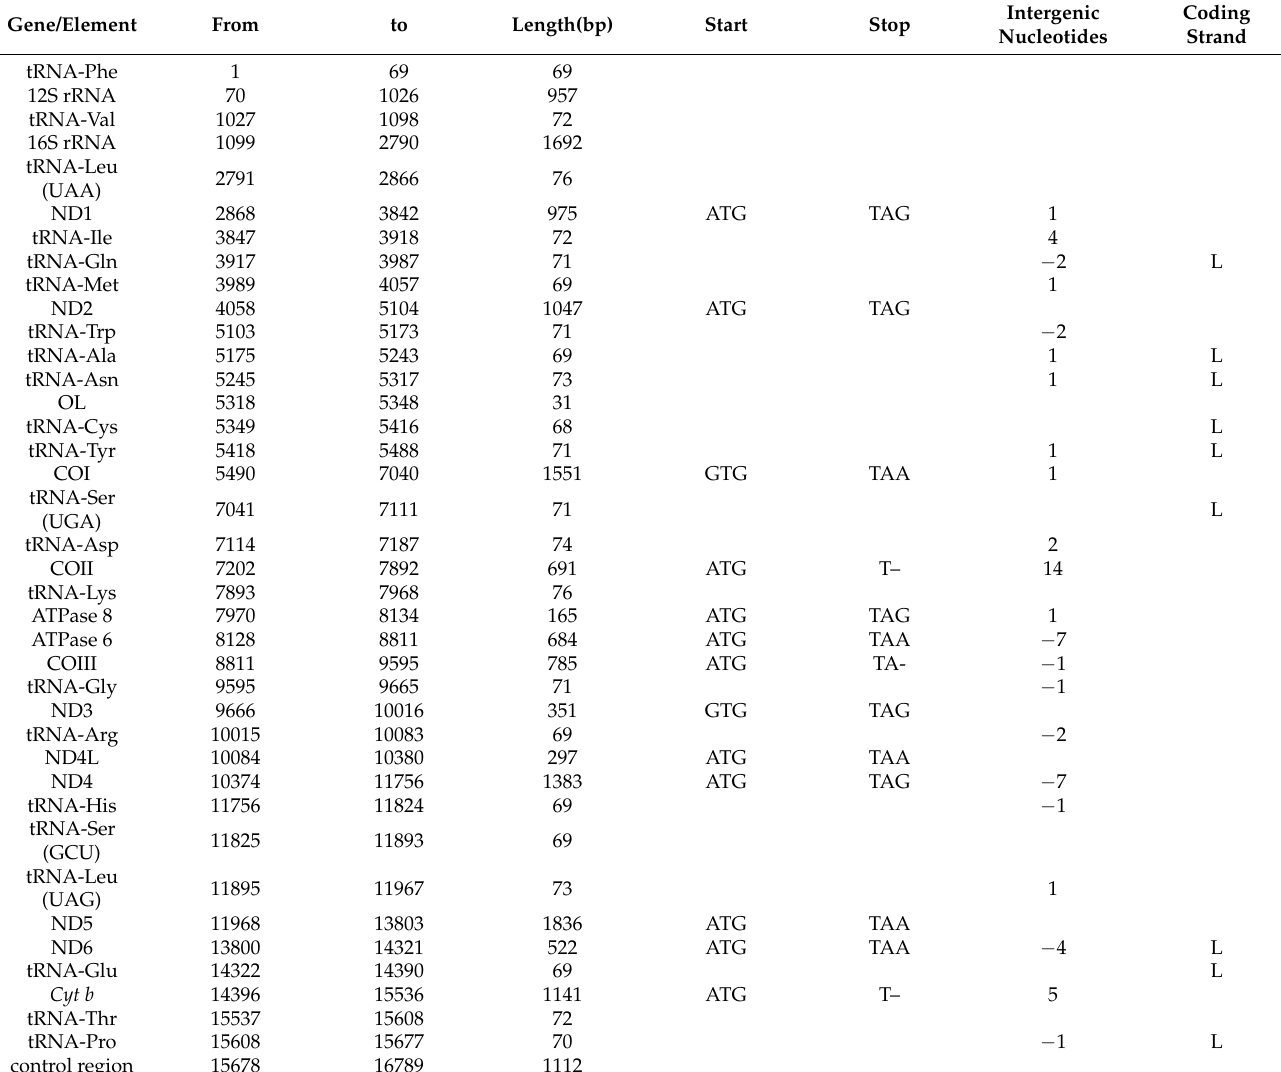
Table 2. Organization of the mitochondrial genome of Phoxinus cf. phoxinus from the Heilongjiang River